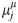
HAFVF predictions after a CC.Each column displays the results of a specific hyperparameter setting. The blue traces and subplots represent the learning in an experiment with a long training, the orange traces and subplots show learning during a short training experiment. A. The stream of observations in the two training cases are shown together with the average posterior expected value of the mean μjμ. The box line width illustrates the ranking of the ELBO of each specific configuration for the dataset considered, with bolder borders corresponding to larger ELBOs. For both training conditions, the winning model (i.e. the model that best reflected the data) was the Long-Short memory model. This can be explained by the fact that the first two models trusted too much their initial knowledge after the CC, whereas the Short-Short learner was too cautious. B. Efficient memory (defined as 1/(1-Eq[·])) for the first level (w^, plain line) and second level (b^, dashed line).